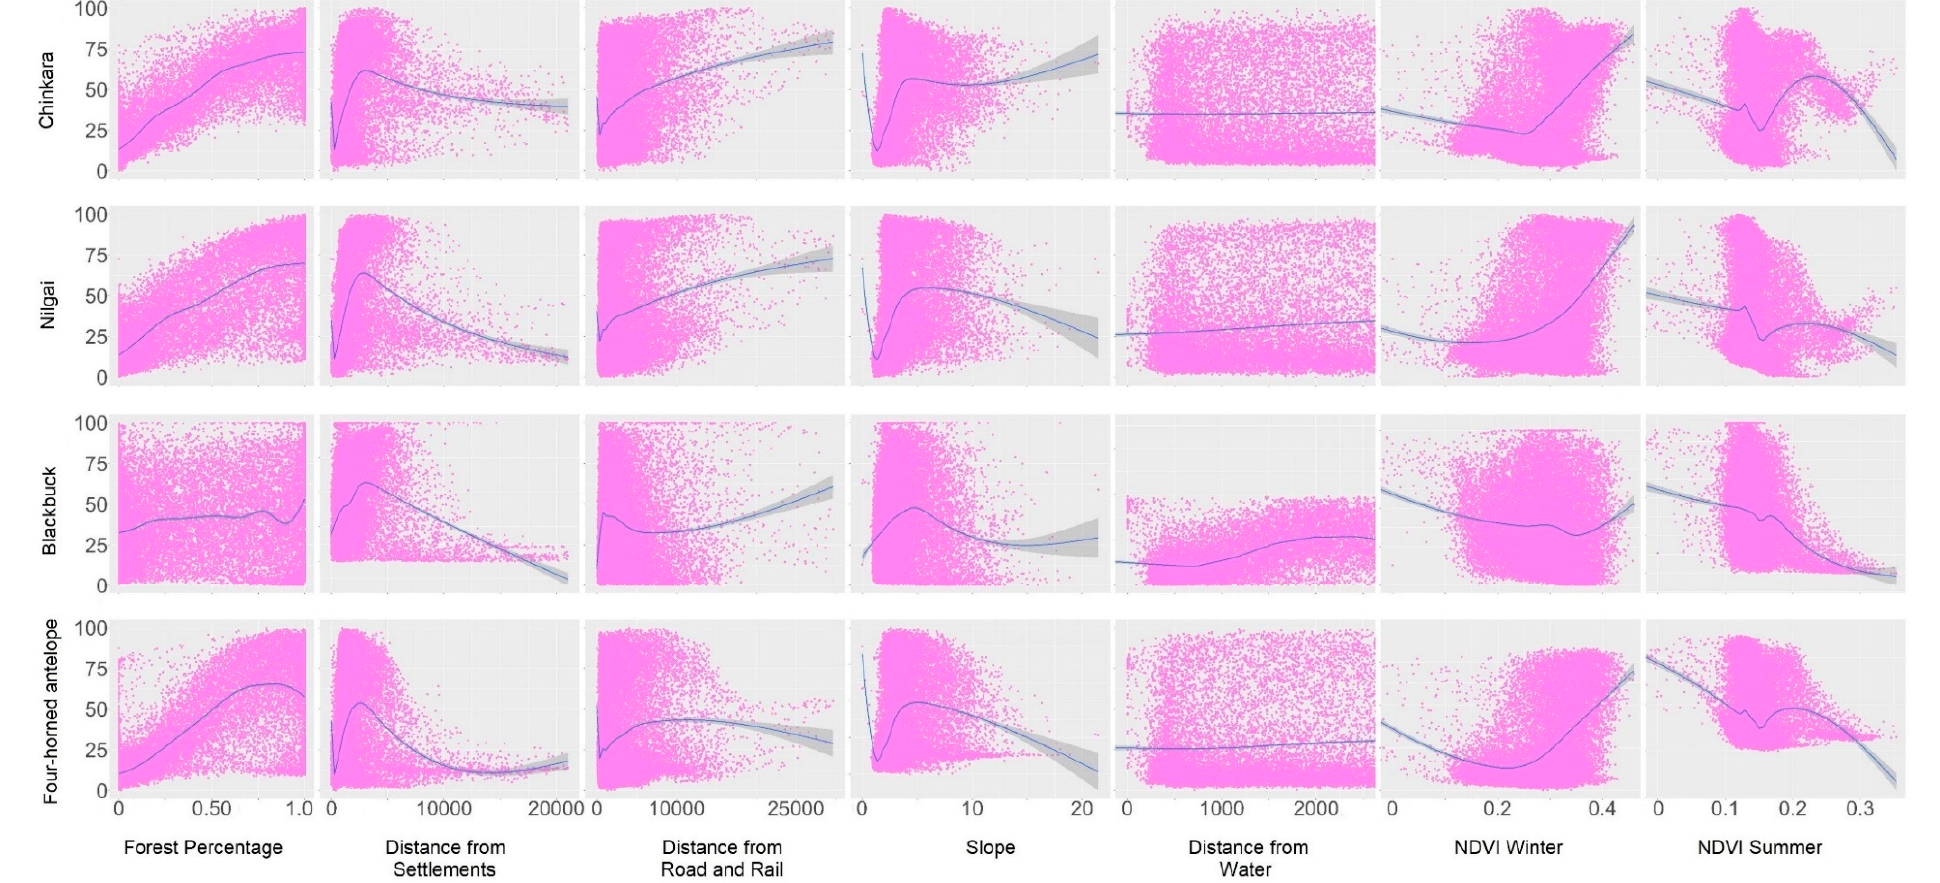
Figure A2. A scatterplot showing the relationship of the predictor variables to the habitat suitability values of the focal species.